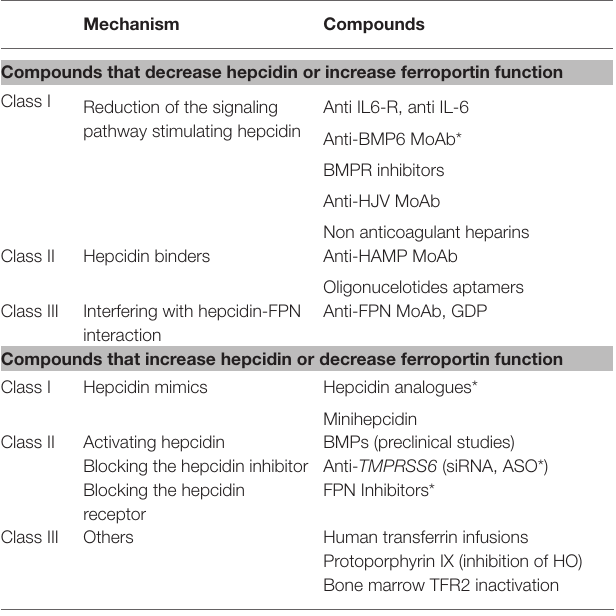
TABLE 2 | Experimental therapies targeting the hepcidin-ferroportin axis.